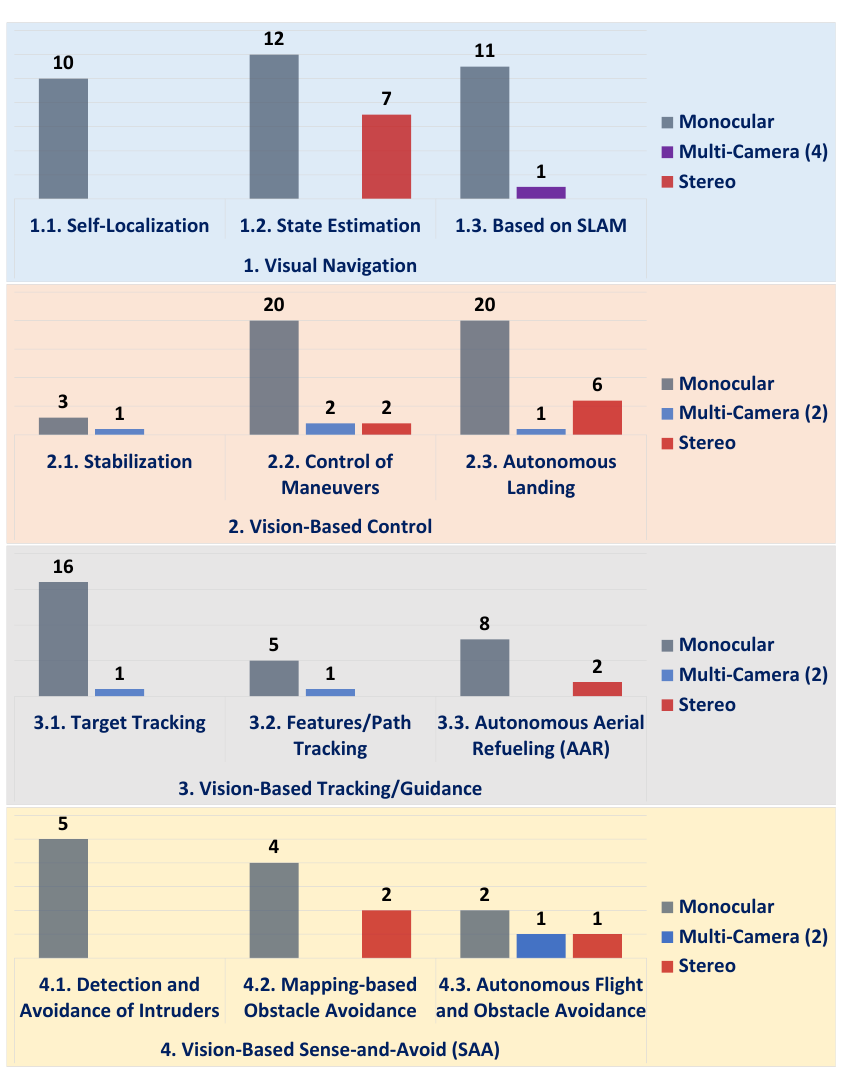
Figure 16. Vision system distribution over the